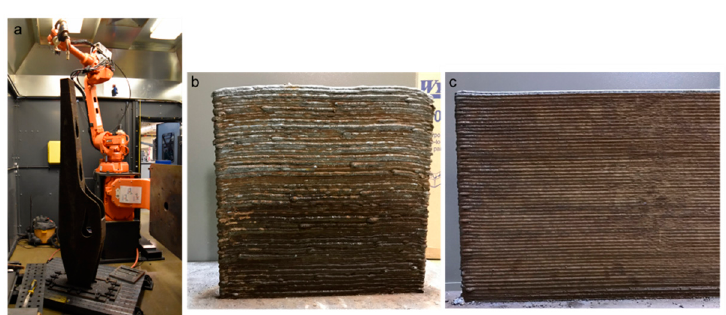
Figure 2. ( a ) Metal Big Area Additive Manufacturing (MBAAM) system with a printed excavator arm. ( b ) Build without the compensation-based approach. ( c ) Build with the compensation-based approach.